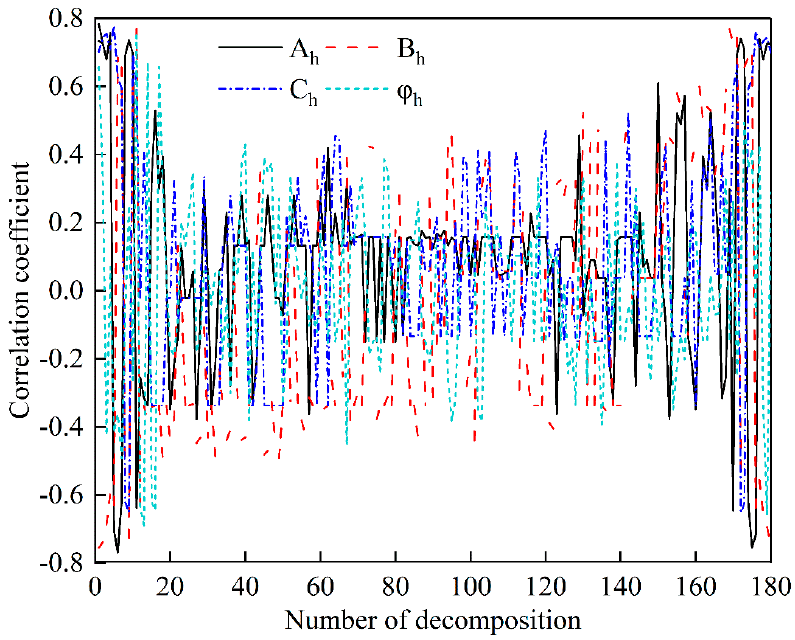
Figure 7. The Pearson correlation coefficient between harmonic characteristic parameters and SMC.